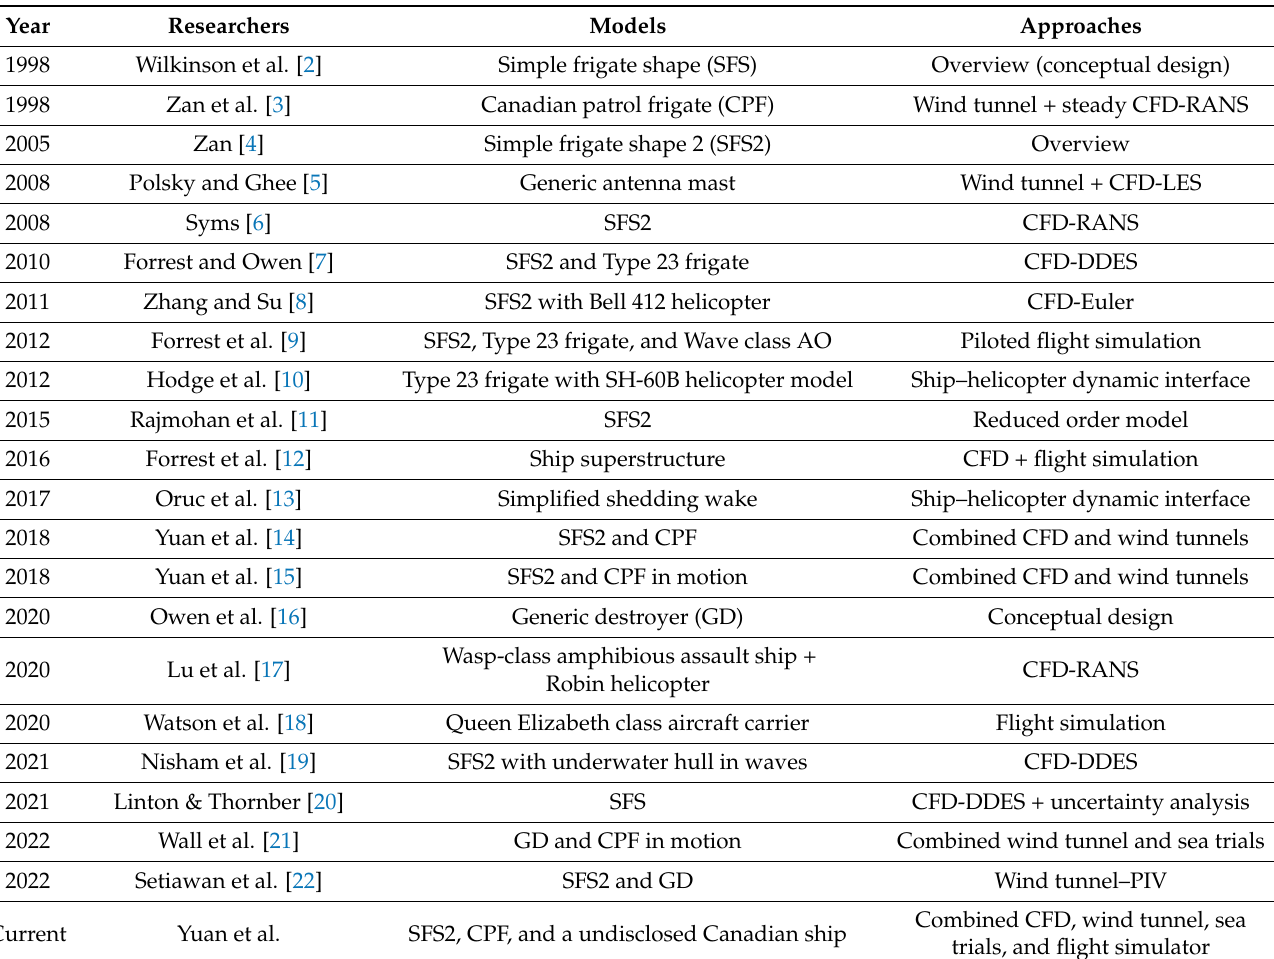
Table 1. Brief of previous studies in ship airwake